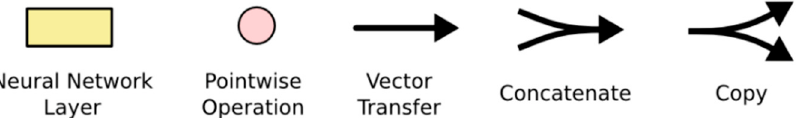
Figure 5. All the annotations in Figure 4.